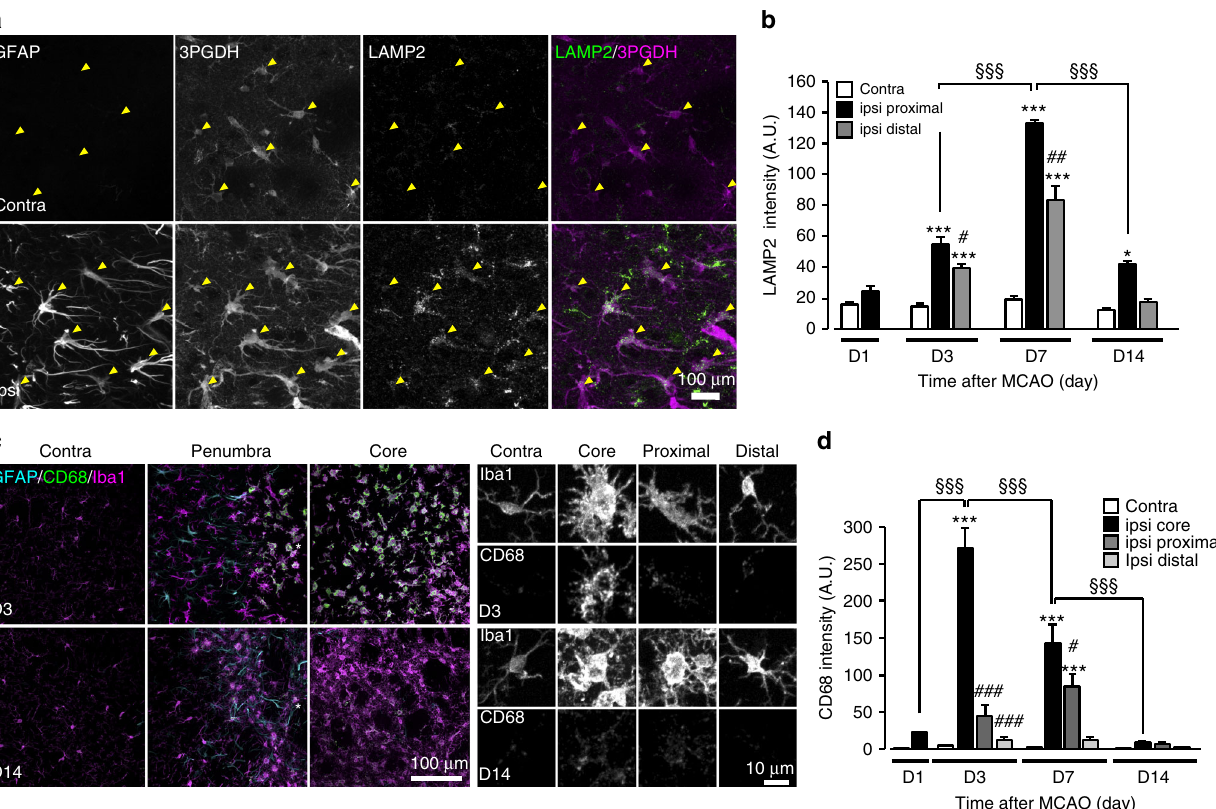
Fig. 5 Spatiotemporal differences in lysosomal protein between astrocytes and microglia. a Representative images of GFAP, 3PGDH, and LAMP2 immunoreactivity in the contralateral striatum ( upper ) and the ischemic penumbra of the ipsilateral striatum ( lower ) at 7 days after MCAO. Arrowheads indicate astrocytes ( n = 10 mice). Forty images per z-stack image (0.47 µ m step). b Quanti fi cation of LAMP2 immunoreactivity mean intensity in 3PGDH + astrocytes after MCAO ( n = 9, 9, 9, 16, 24, 9, 18, 26, 9, 16, 24 fi elds, 3, 4 mice, * P < 0.05, *** P < 0.001 vs. contra (corresponding day), # P < 0.05, ## P < 0.01 ipsi (proximal) vs. ipsi (distal), §§§ P < 0.001 vs. ipsi proxymal D7, one-way ANOVA ( P < 0.0001) with Tukey ’ s multiple comparison test). c Representative images of GFAP, CD68, and Iba1 immunoreactivity in the ischemic core, penumbra, and contralateral striatum at 3 and 14 days after MCAO ( n = 4 mice). High-magni fi cation images are shown in the right panel . Eighteen images per z-stack image (1.0 µ m step). d Quanti fi cation of CD68 immunoreactivity mean intensity in Iba1 + microglia after MCAO ( n = 8, 8, 10, 8, 4, 4, 12, 11, 10, 10, 8, 8, 8, 8 fi elds, 4 – 6 mice, *** P < 0.001 vs. contra (corresponding day), # P < 0.05, ### P < 0.001 vs. ipsi core (corresponding day), §§§ P < 0.001 vs. respective ipsi core, one-way ANOVA ( P < 0.0001) with Tukey ’ s multiple comparison test). Values represent means ±